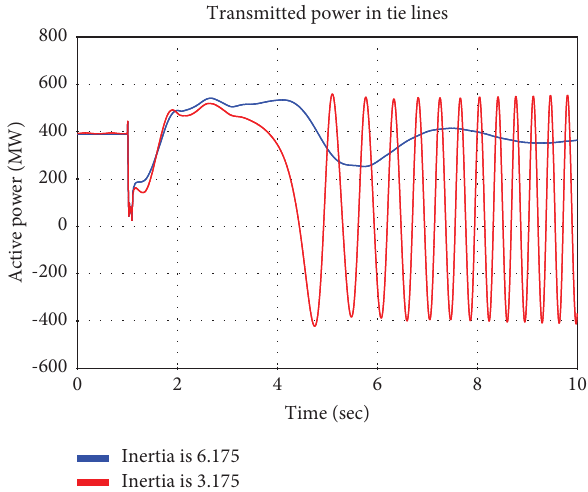
Figure 15: Efect of changing inertia on transmitted power.